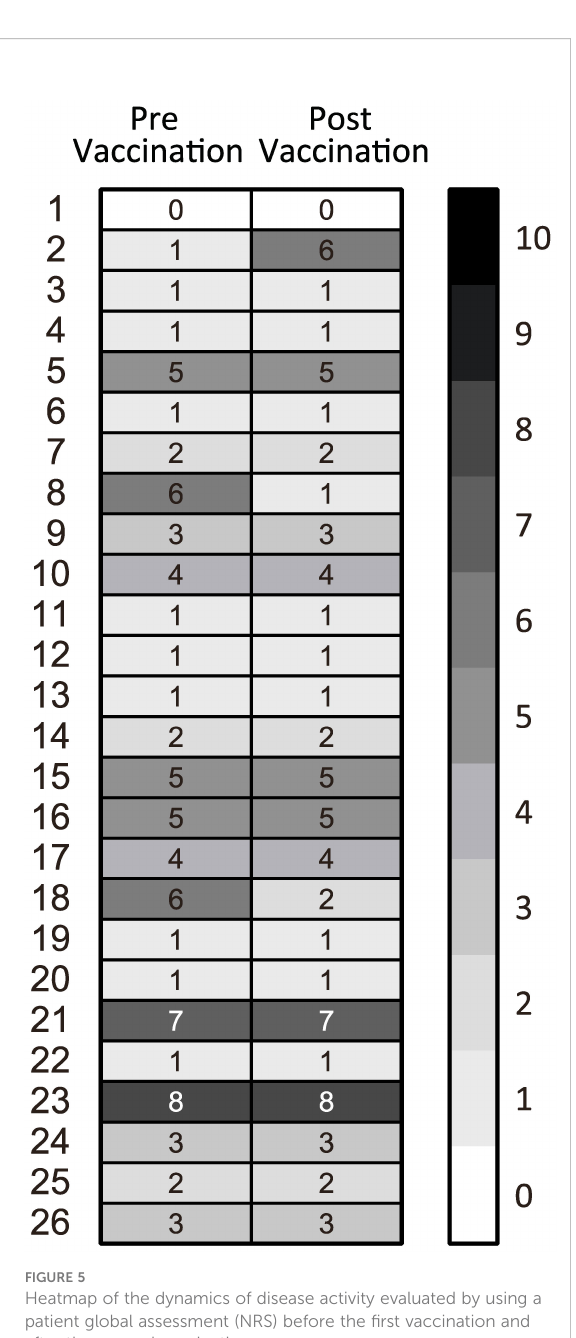
FIGURE 5 Heatmap of the dynamics of disease activity evaluated by using a patient global assessment (NRS) before the fi rst vaccination and after the second